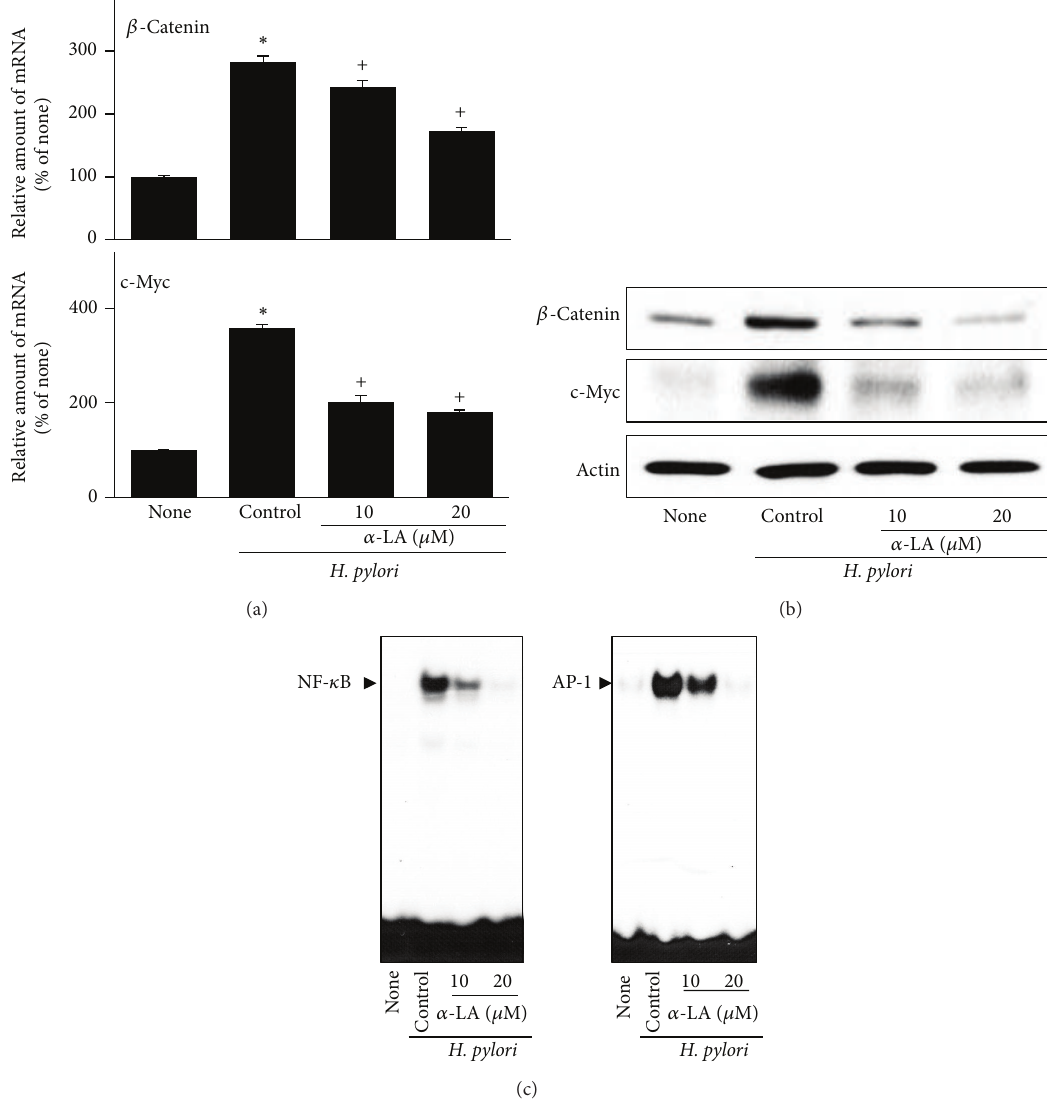
Figure 5: Effect of 𝛼 -LA on expression of 𝛽 -catenin and c-myc as well as activation of NF- 𝜅 B and AP-1 in H. pylori- infected AGS cells. The cells were pretreated with 𝛼 -LA for 2h and cultured in the presence or absence of H. pylori for 24 h (mRNA, protein levels) or 1h (activation of NF- 𝜅 B and AP-1). (a) mRNA expression of 𝛽 -catenin and c-myc was measured by real-time PCR analysis. (b) Protein levels of 𝛽 -catenin and c-myc were determined by Western blot analysis. Actin served as a loading control. (c) EMSA was performed for DNA binding activities of NF- 𝜅 B and AP-1. ∗ 𝑃 < 0.05 versus none (the cells cultured in the absence of H. pylori ); + 𝑃 < 0.05 versus control (the cells cultured in the presence of H. pylori and treated without 𝛼